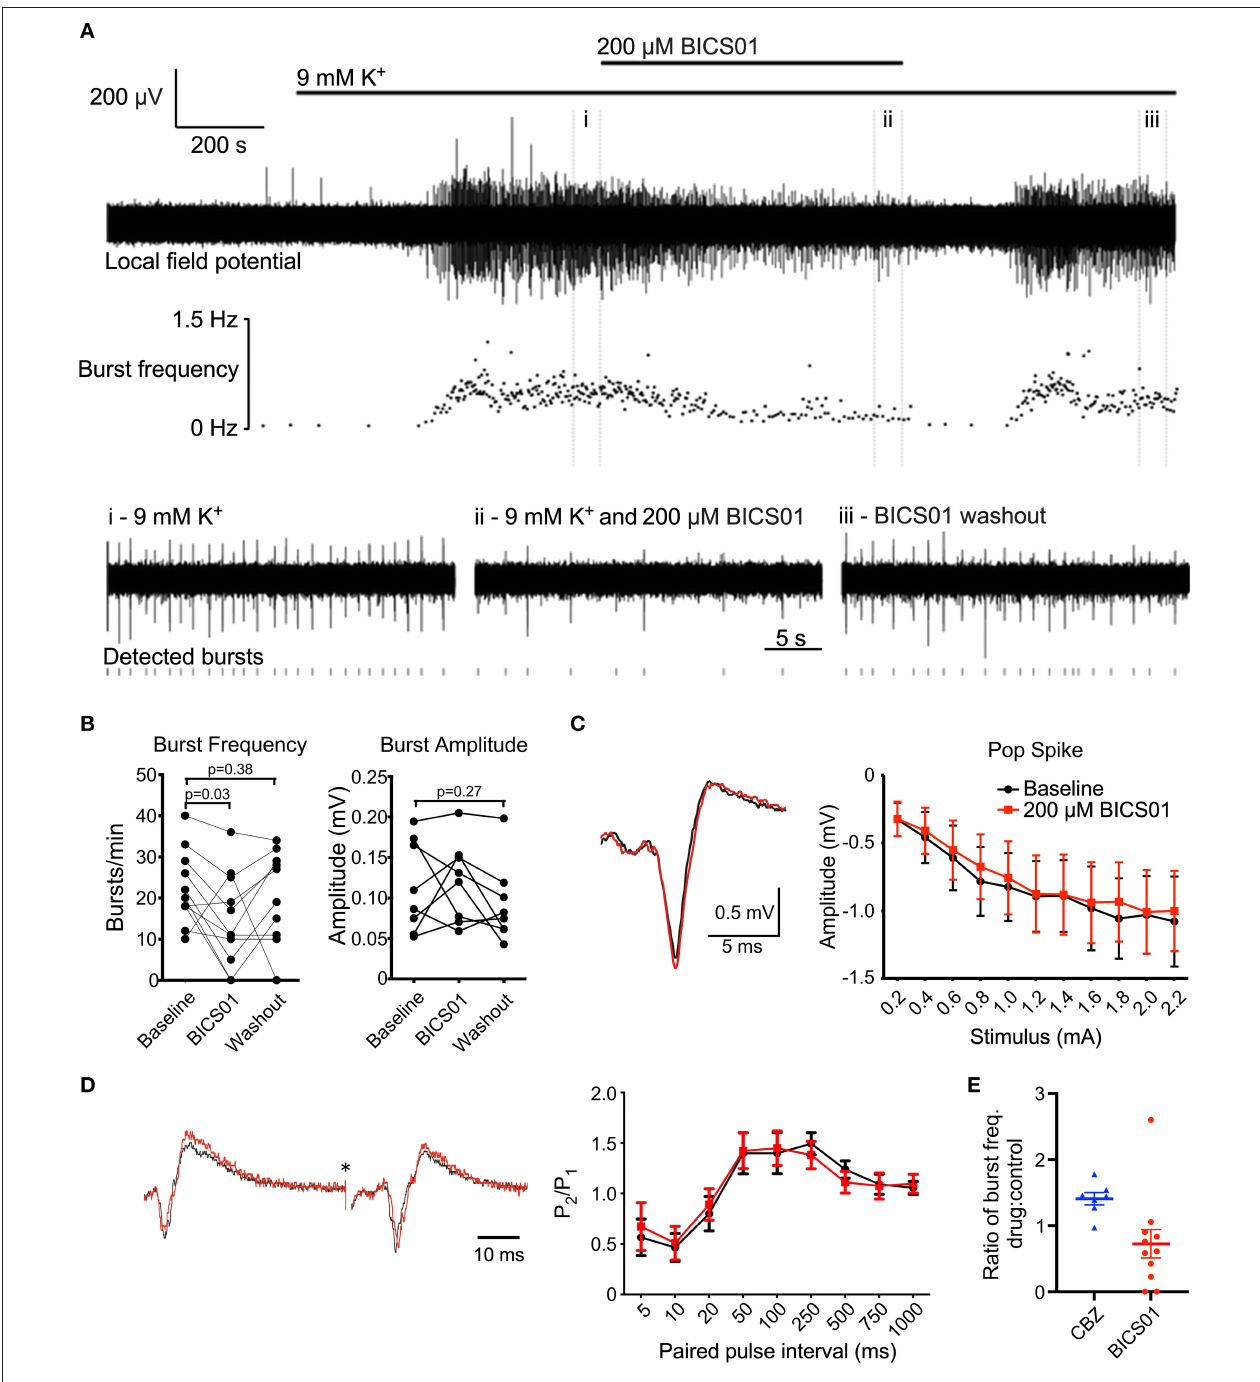
FIGURE 1 | BICS01 reduces epileptiform bursting in hippocampal slices treated with 9mM K + . (A) Representative trace showing epileptiform bursting in hippocampal CA1 elicited by 9mM K + , before (i), during (ii) and after (iii) application of 200 µ M BICS01. Raster plot shows instantaneous burst frequency throughout the experiment. (B) Summary data shows a significant decrease in burst frequency in the presence of 200 µ M BICS01, which is reversed upon washout (RM one-way ANOVA with Dunnet’s post hoc tests; p values marked on graph). Changes in burst amplitude caused by 200 µ M BICS01 were not consistent between slices. (C) Stimulus-response curves and (D) paired-pulse facilitation are not altered by BICS01 ( * truncated stimulus artifact, and amplitude of traces in (D) normalized to response to the first pulse). (E) 200 µ M BICS01 mediates a stronger reduction in epileptiform bursting then 30 µ M carbamazepine [CBZ data from (12)].